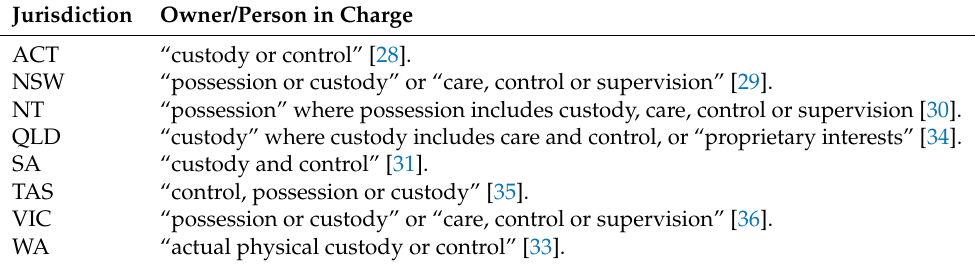
Table 4. Statutory definition of ‘owner/person in charge’ in each state and territories’ animal welfare